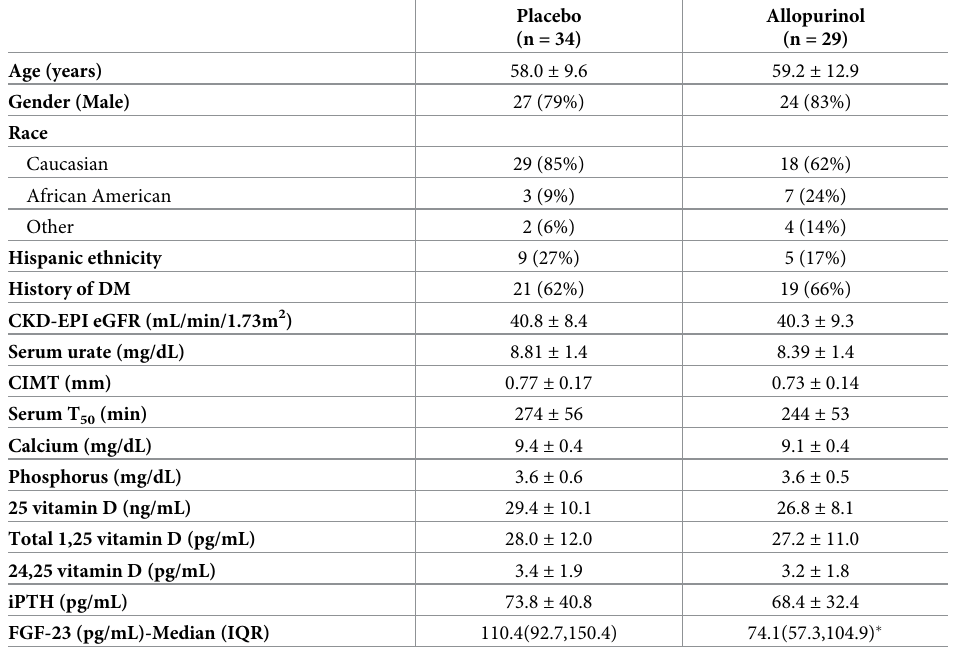
Table 1. Baseline characteristics of the subset of subjects with CKD-MBD measurements according to study